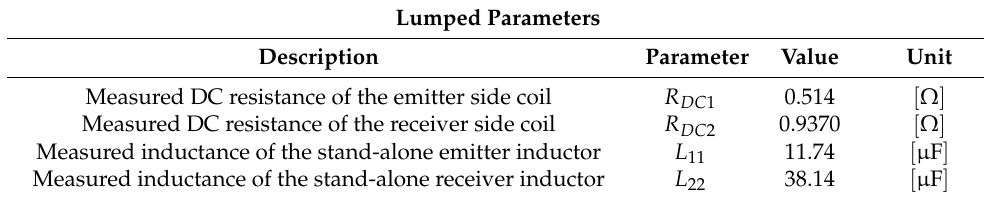
Table 1. Measured values of the stand-alone inductors.